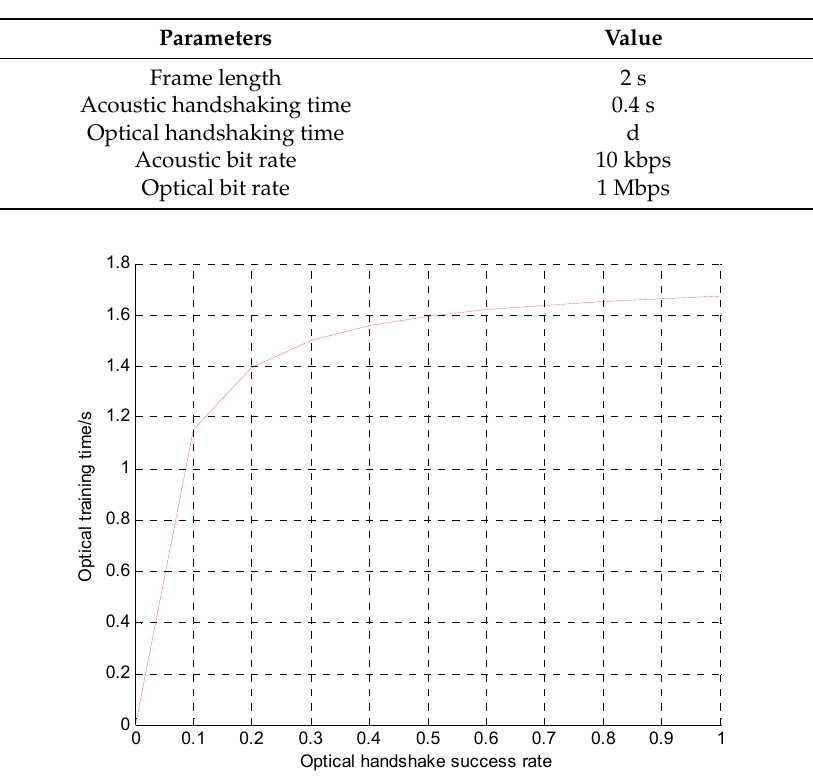
Figure 4. Relationship between optical handshake success rate and optical handshake time.